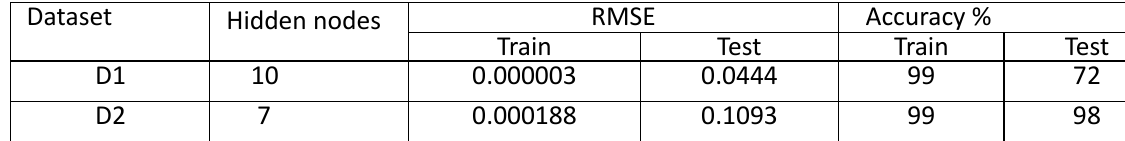
Table three: Results on training as well as testing